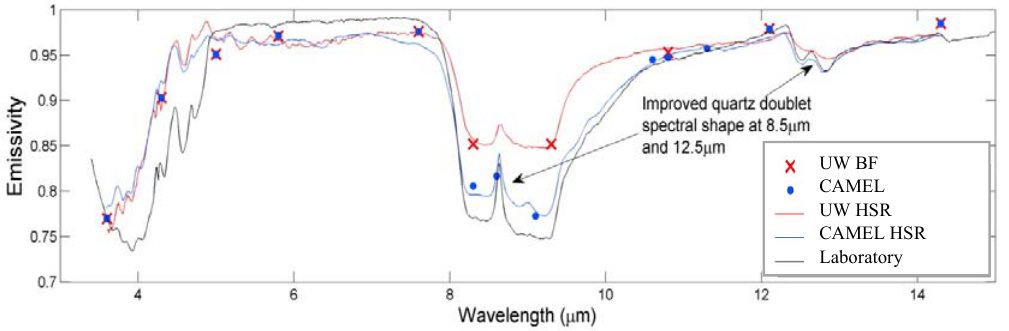
Figure 8. The advantages of combining the ASTER GEDv4 and UW BF databases are evident here, showing the emissivity spectra over the Namib Desert, Namibia. UW BF emissivity for January 2004 (crosses) and hyperspectral fit (red line), the CAMEL 13 hinge-point emissivity (blue dots) and hyperspectral fit (blue line), and lab spectra (black) of sand samples collected over the Namib Desert. Note the improved spectral shape in CAMEL HSR (blue) in the quartz doublet regions between 8–10 µm and 12–13 µm.